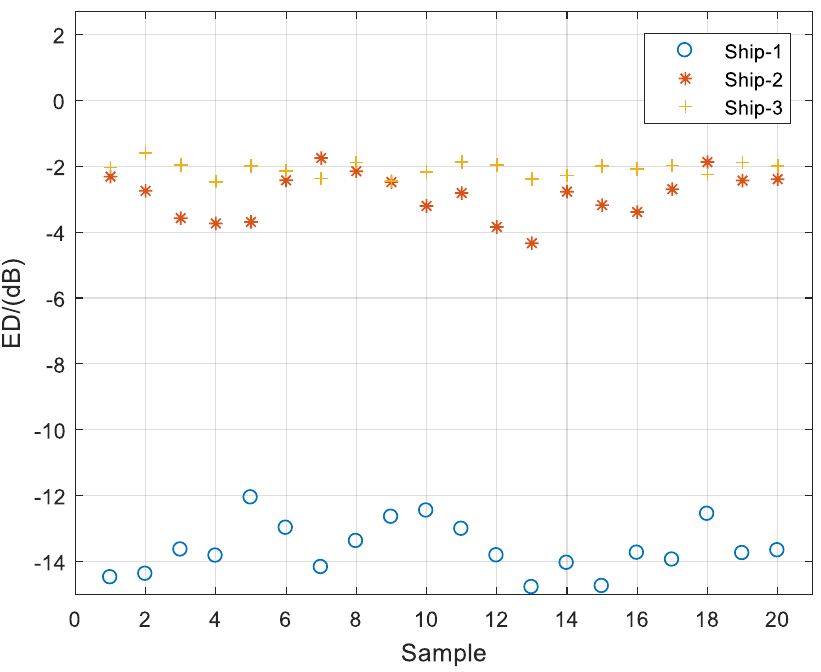
Figure 4. The energy of the low-frequency and the high-frequency band for S-RN signals. Table 1. The ED for S-RN signals. S-RN: ship-radiated noise, ED: energy difference.